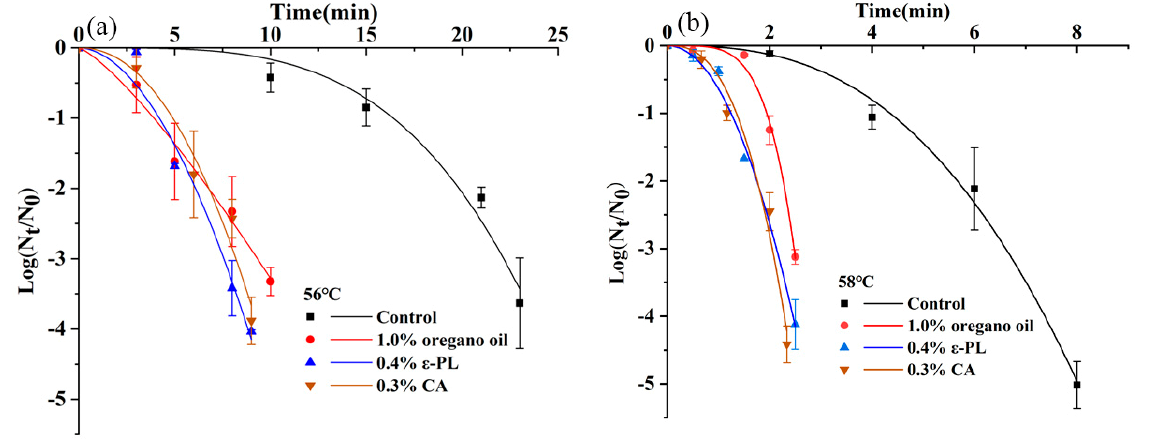
Figure 7. Inactivation curves of S. Montevideo CICC 21588 in diluted tahini using heating (( a ): 56 °C or ( b ): 58 °C) combined with oregano oil, CA and ε -PL.